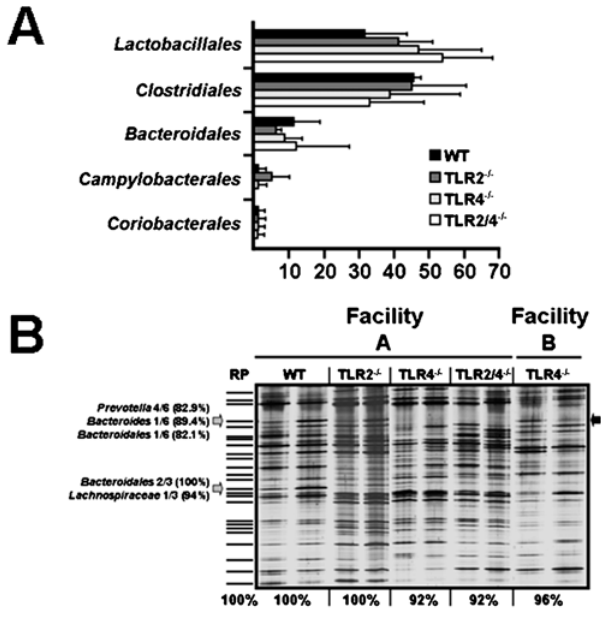
Figure 3. Molecular gut flora analysis in mice lacking TLR2 and/or TLR4. Detailed molecular investigations of the colon microbiota in three months old C57BL/10 mice lacking TLR2, TLR4, or both were performed by analysis of 16S rRNA gene libraries (A) or high-resolution DGGE (B) with primers HDA-1-GC and HDA-2 (see methods). ( A ) Results from gene library analysis. Complete 16S rRNA genes were amplified from total luminal colon content DNA isolated from wt mice (WT, n=3), and from mice (n=3 each group) lacking TLR2 (TLR2 -/- ), TLR4 (TLR4 -/- ), or both (TLR2/4 -/- ). The amplicons were cloned and sequenced as described in the Methods section. Bars represent percentage amounts of gut bacterial groups indicated on the Y-axis. ( B ) Results from DGGE analysis of PCR-amplified total bacterial 16S rRNA gene fragments. Each lane shows DGGE profiles of the bacterial flora from the colon of healthy wt mice, and animals lacking TLR2 (TLR2 -/- ), TLR4 (TLR4 -/- ), or both (TLR2/4 -/- ). Mice of identical age (three months) originated from two different animal facilities (as indicated above the lanes). DNA bands, which were absent or weak in DGGE profiles from TLR4 -/- and TLR2/4 -/- animals are marked by grey arrows. Bacterial species identified by sequence analysis of 16S rRNA gene fragments in the corresponding bands are indicated on the left. Total numbers of DGGE bands in the profile from wt animals were counted and set to 100% in the reference pattern (RP). Presence and absence of bands in profiles from the respective TLR-deficient animals was recorded and similarity values were calculated and expressed as % similarity to the wt RP. The DGGE profiles are representative for at least three mice per group and experiment. Results were reproduced in two independent experiments.